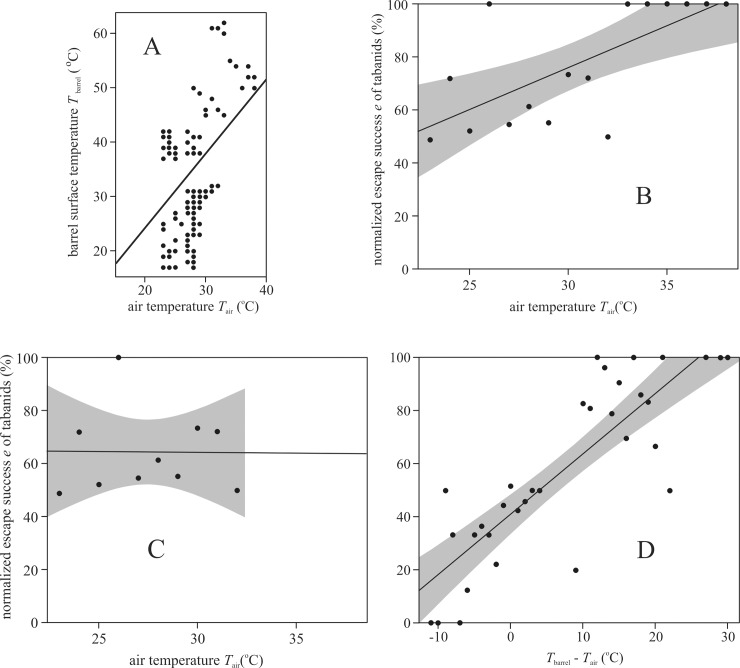
Normalized escape success versus temperatures.(A) The barrel surface temperature Tbarrel (oC) versus air temperature Tair (oC) in field experiments 1–5. A straight line indicates the linear fit to the Tbarrel (Tair) data (black circles). (B) Normalized escape success e versus Tair (oC) for all five experiments. (C) As B, but only for Tair ≤ 32°C. (D) Normalized escape success e versus Tbarrel—Tair (oC) for all five experiments. In B-D continuous straight lines indicate the linear fit to the data (black circles), and dark grey bands around the fit show the 95% confidence intervals.